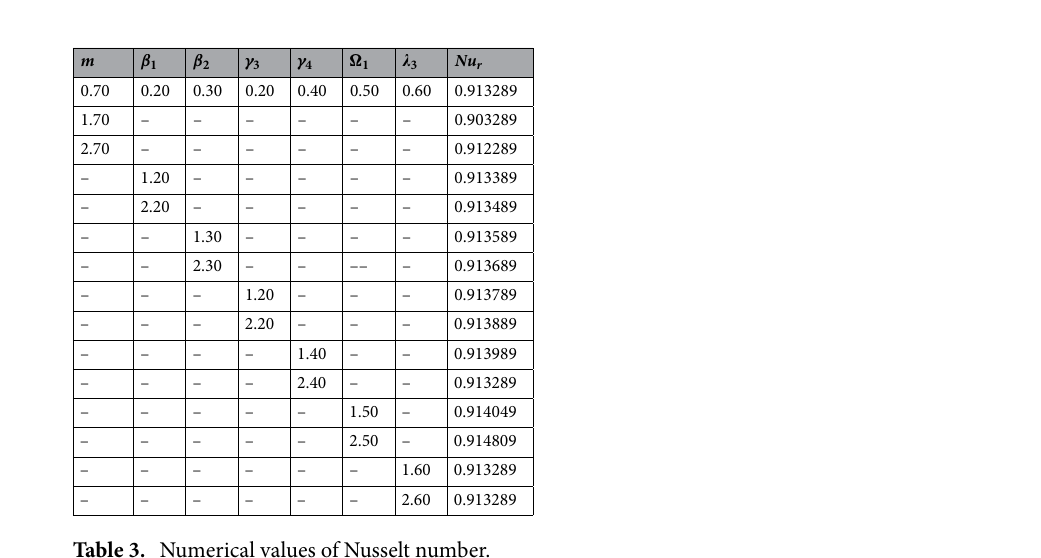
Table 3. Numerical values of Nusselt number.